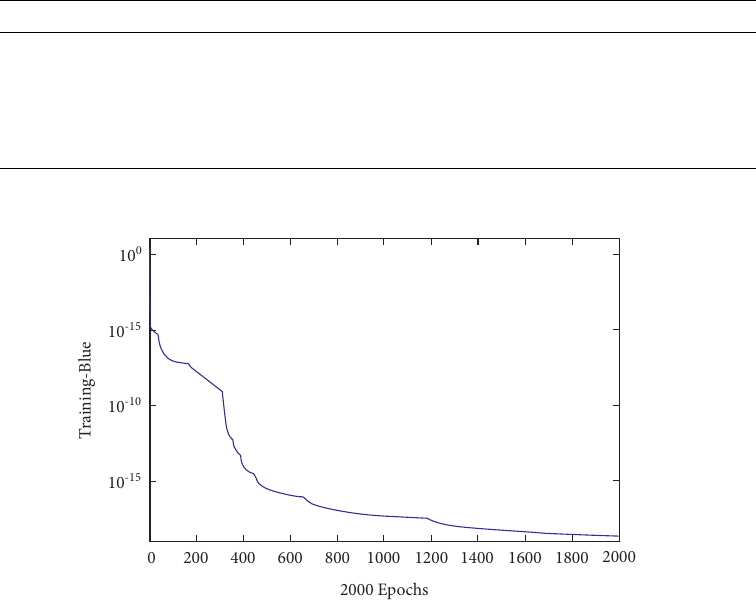
Figure 5: Training convergence curve of the neural network model. Table 9: The results of parametric